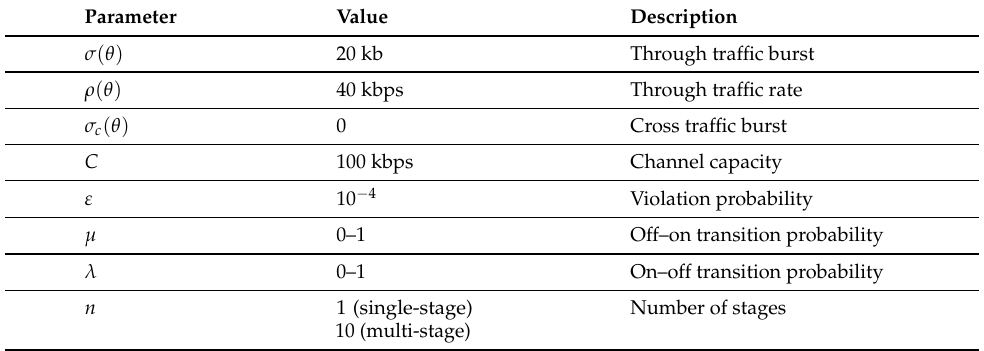
Table 1. Parameters used in the